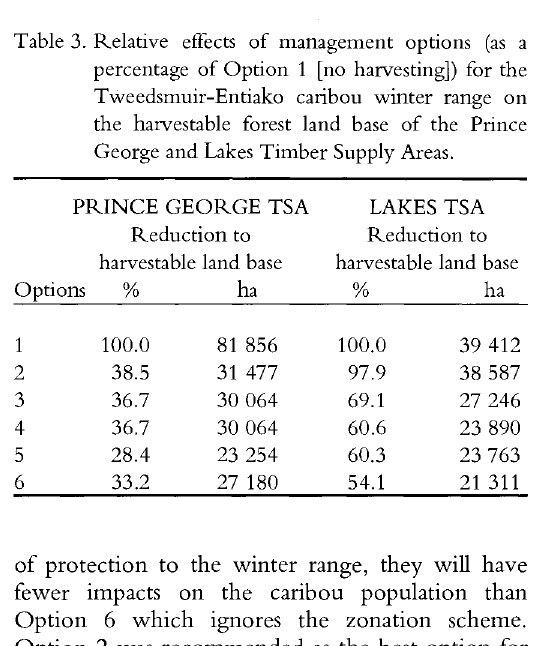
Table 3. Relative effects of management options (as a percentage of Option 1 [no harvesting]) for the Tweedsmuir-Entiako caribou winter range on the harvestable forest land base of the Prince George and Lakes Timber Supply